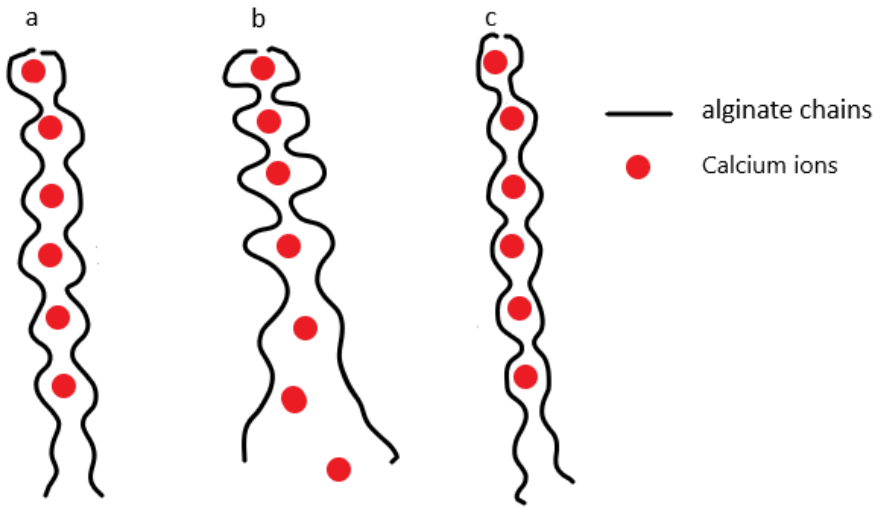
Figure 3. Schematic shows that ( a ) alginate chains are ionically chelated by Ca 2+ , and ( b ) under mechanical stress, the alginate–Ca 2+ connections are pulled apart, and the fracture of these physical bonds dissipates mechanical energy; ( c ) upon removal of mechanical stress, the ionic cross-links are able to recover.